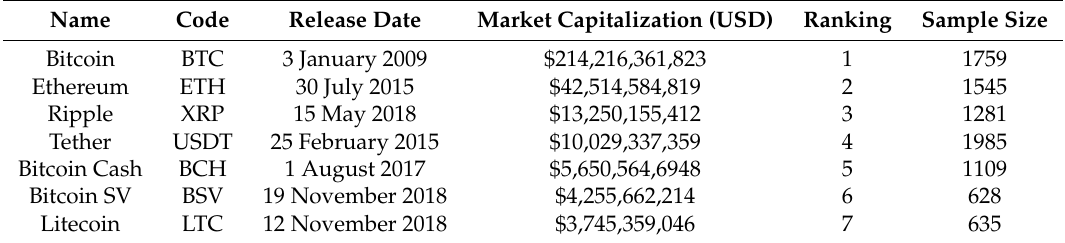
Table 2. Cryptocurrency